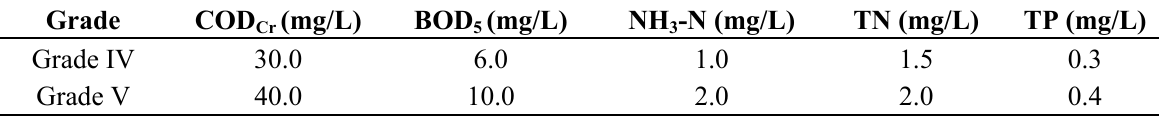
Table 4. Water quality standards of surface water